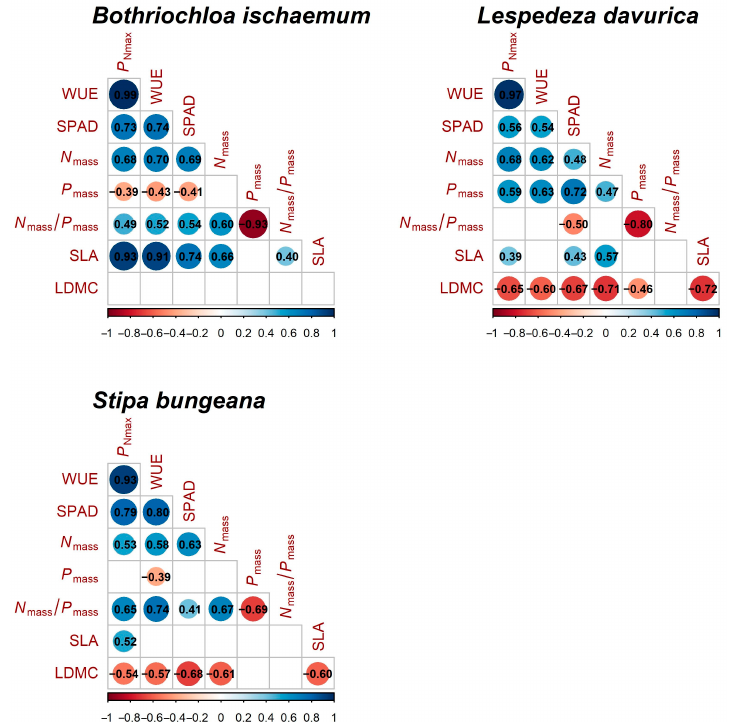
Figure 7. Heatmap of Pearson correlation testing relationships between P Nmax , WUE, and leaf functional traits ( N mass , P mass , SLA, and LDMC) in the three species. Numbers in circles indicate the Pearson correlation coefficients.